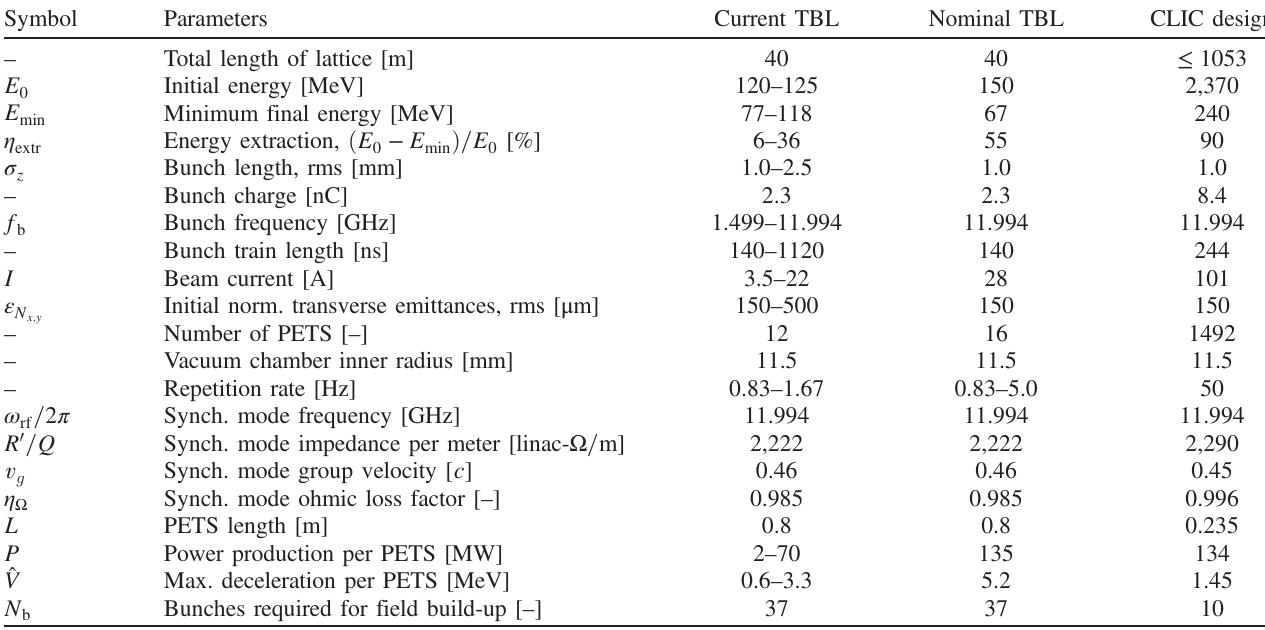
TABLE I. Beam, lattice, and PETS structure parameters. Nominal parameters are given for both the TBL and one CLIC decelerator, in addition to currently achieved numbers for the